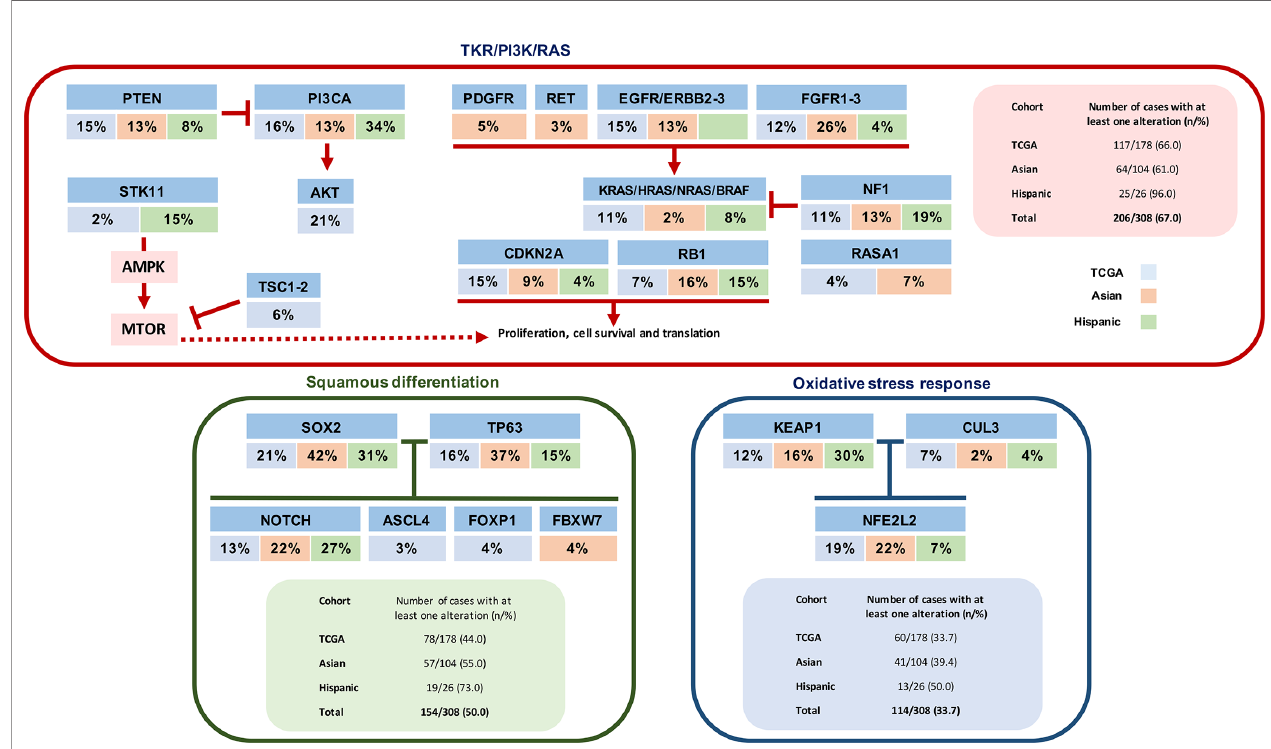
FIGURE 4 | Diagram integrating three different core pathways of lung squamous cell carcinoma (considering information of substitution mutations, truncating mutations, ampli fi cations, and deletions) from the information provided by Korean cohort (18) and by TCGA